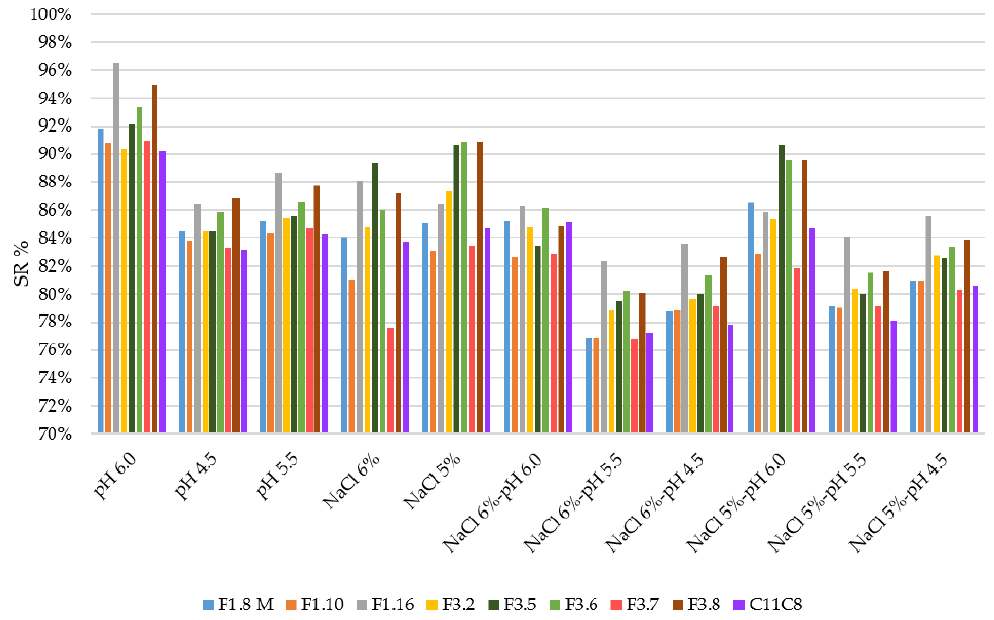
Figure 2. Survival rate plot of the strains, expressed in percentage values, under single and combined stress conditions at 16 °C.